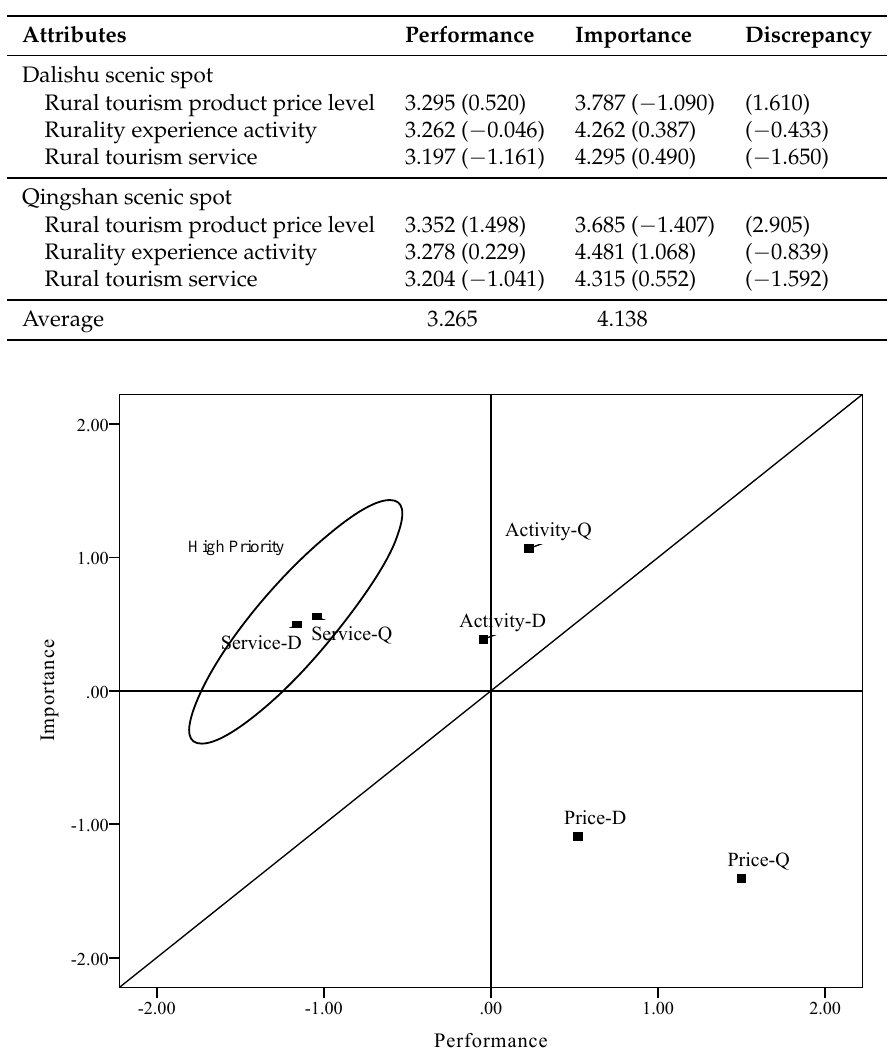
Figure 7. Traditional importance-performance grid (D: Dalishu scenic spots; Q: Qingshan scenic